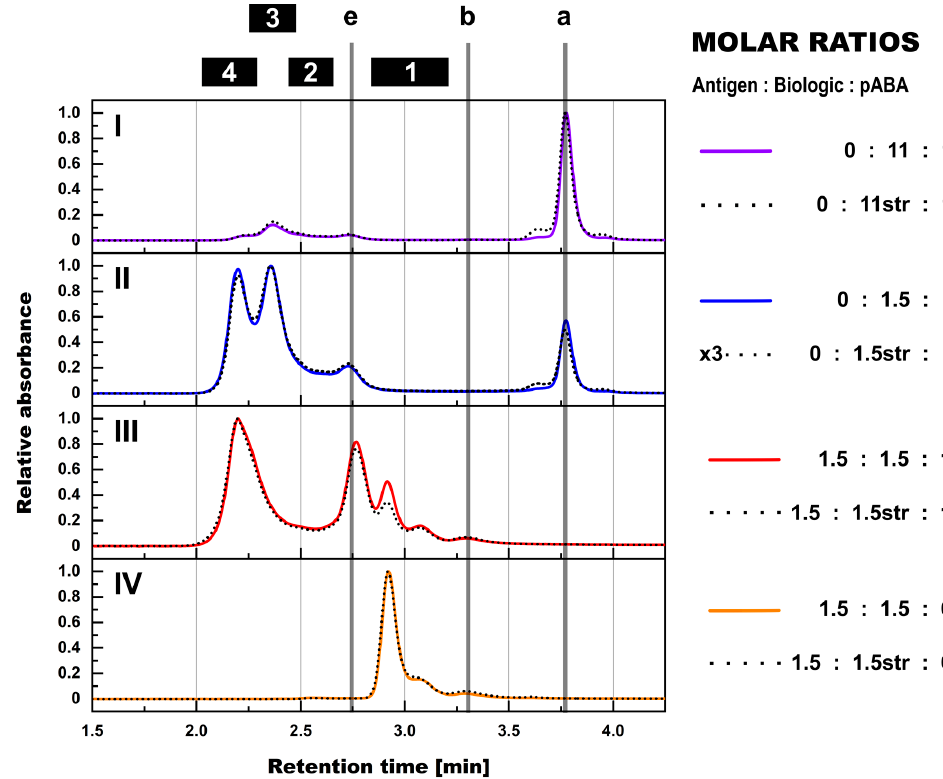
Figure 5. SEC assessment: impact of biologic material degradation on formation of immune com- plexes in PBS matrix. Normalized SEC-UV profiles are shown for antigen:biologic:pABA compositions of the following molar ratios—0:11:1 on panel ( I ), 0:1.5:1 on panel ( II ), 1.5:1.5:1 on panel ( III ), and 1.5:1.5:0 on panel ( IV ), whereby full lines represent compositions using non-stressed biologic material and dotted lines represent compositions using stressed material (performed in triplicate for the 0:1.5:1 composition). Marker: (a) free biologic, (b) free antigen, (e) free pABA, (1) antigen:biologic complexes, (2) immune complexes with a single ABA incorporated, (3) immune complexes with two incorporated ABAs, (4) immune complexes with more than two incorporated